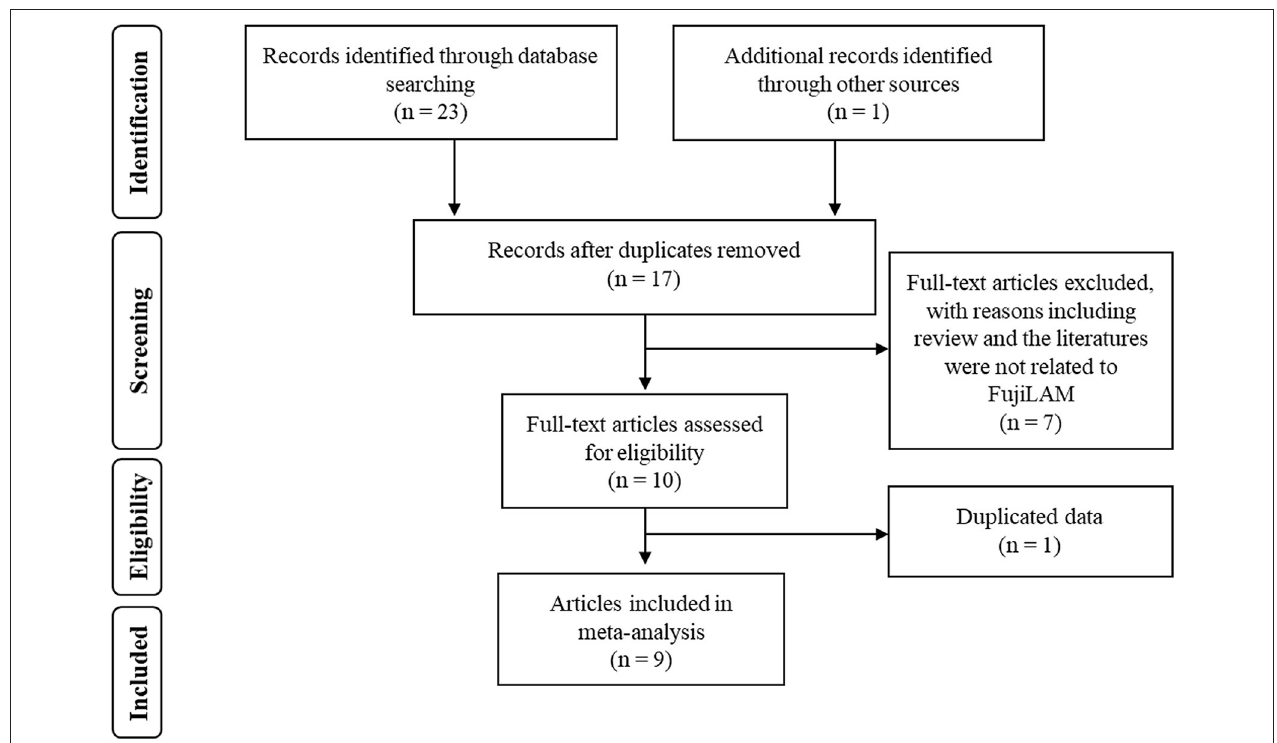
FIGURE 1 | The flow diagram of included and excluded